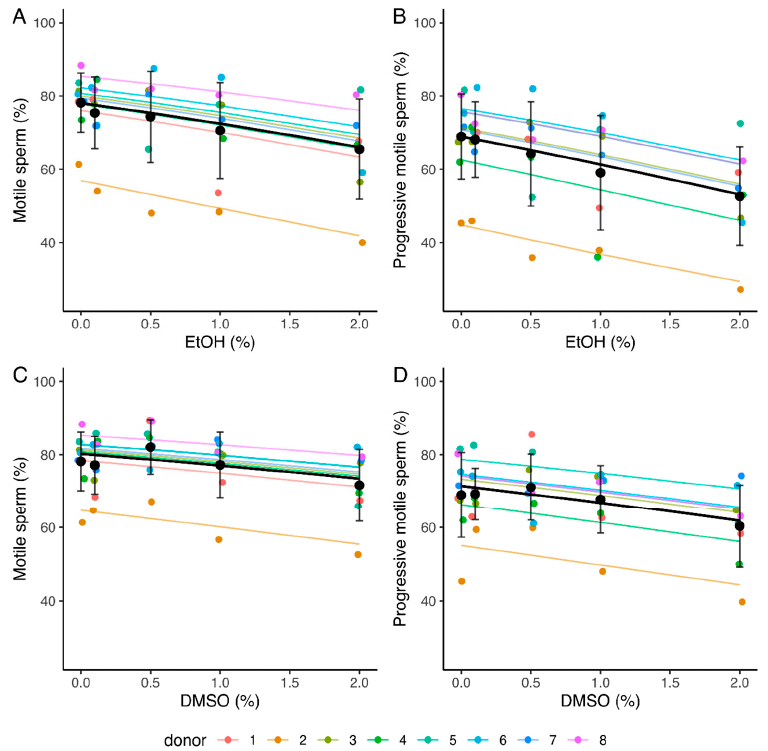
Figure 1. Influence of increasing concentrations of ethanol (EtOH) and dimethyl sulfoxide (DMSO) on total ( A , C ) and progressive ( B , D ) sperm motilities after a 4 h incubation. Values for each replicate (n = 8) are highlighted by a dot whose color refers to a donor. Colored lines represent the model fit for each donor. Black dots represent mean values for each concentration ± SD. Black lines correspond to the mean effect across all donors (Tables 2 and S3).